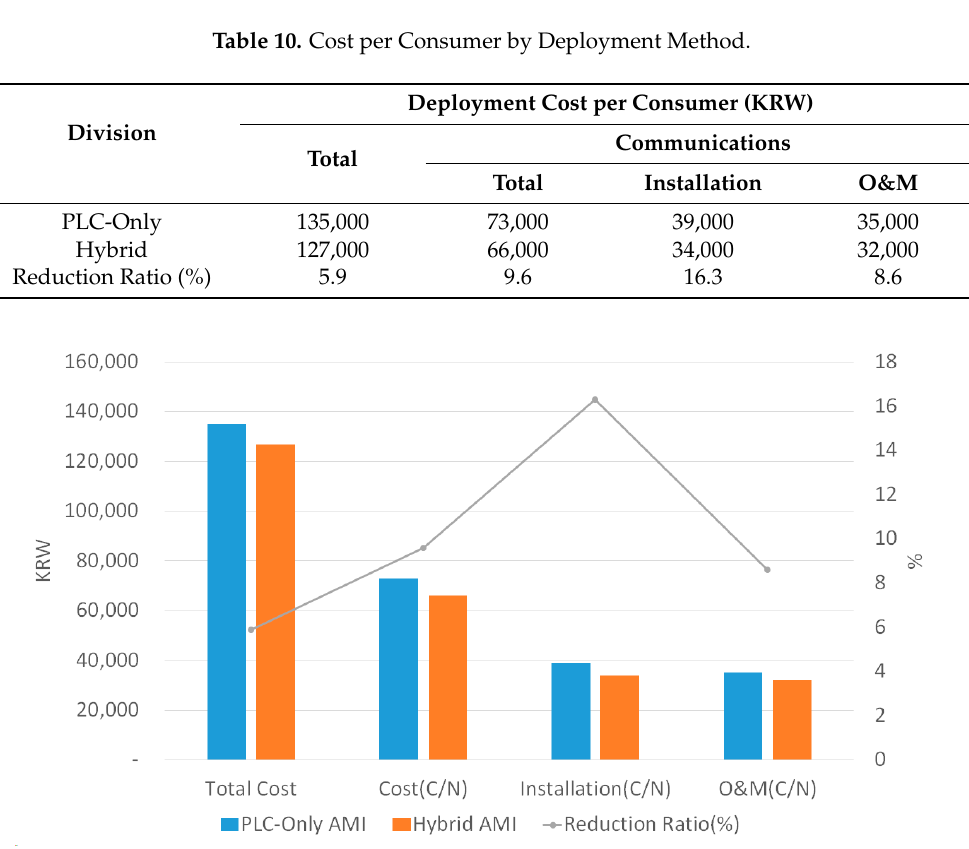
Figure 8. Cost per Consumer by Deployment Method.